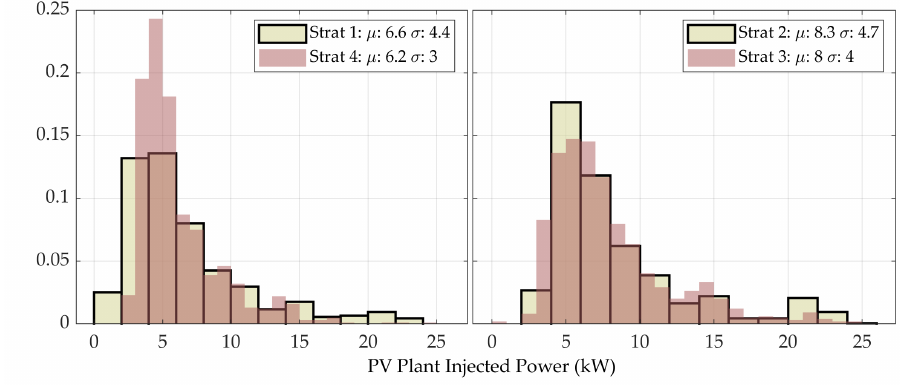
Figure 7. Maximum PV injection at fixed